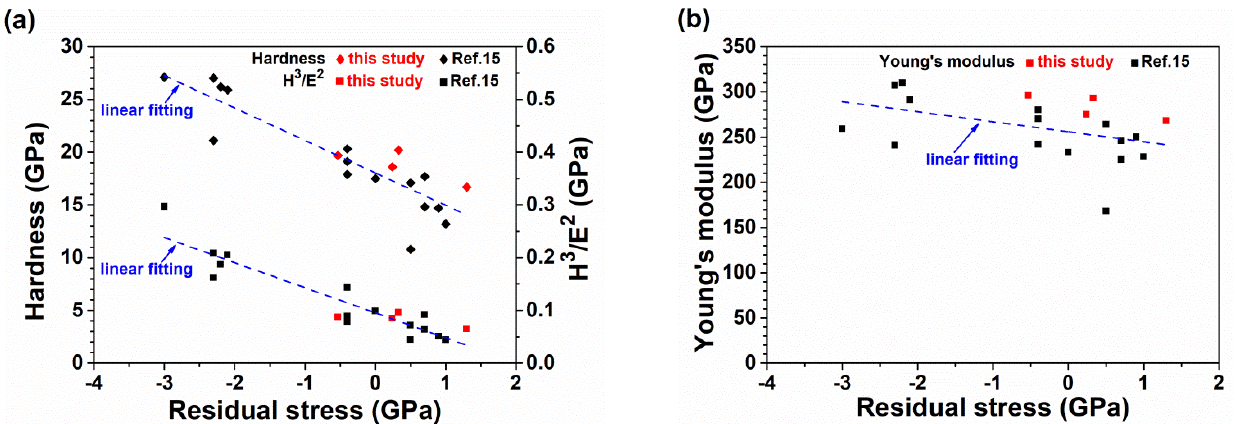
Figure 7. Relationship between ( a ) hardness and H 3 /E 2 levels and ( b ) Young’s modulus against residual stresses of the CrWN coatings.